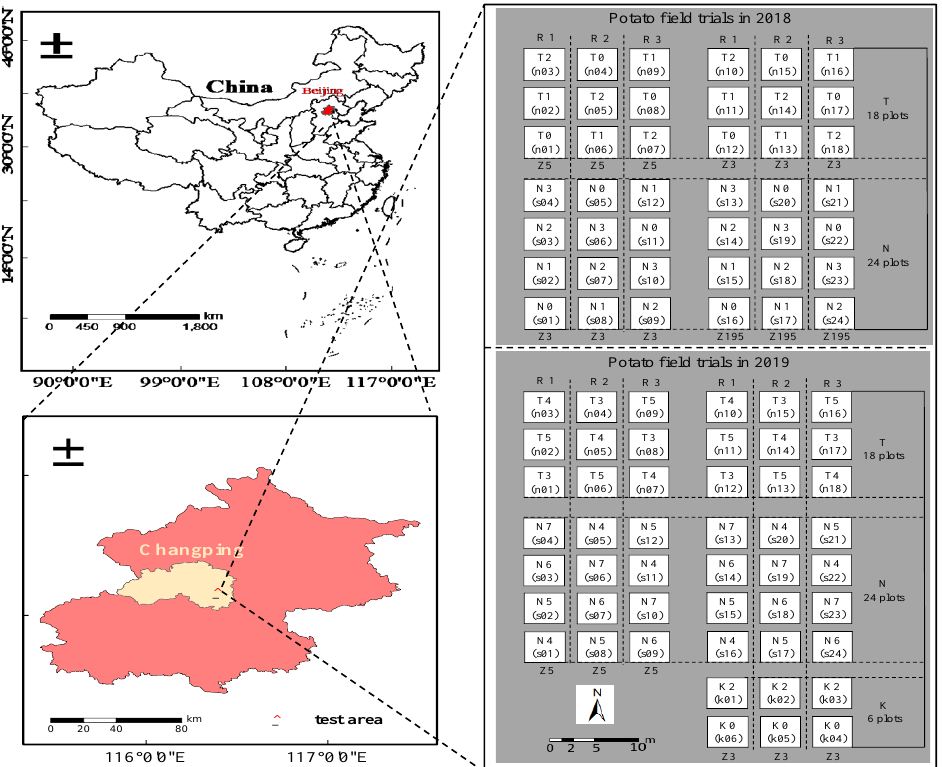
Figure 1. Location of potato field and experimental design. Note: R is an abbreviation for Replica- tion.